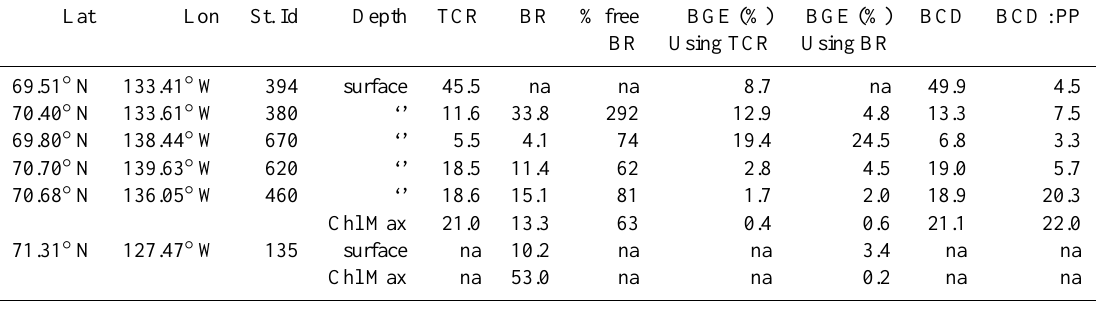
Table 2. Total community respiration (TCR, mgCm − 3 d − 1 ), free-living bacterial respiration (BRmgCm − 3 d − 1 ), percentage of respiration associated to free-living bacteria (%), bacterial growth efficiency (BGE, %), bacterial carbon demand (BCD, mgCm − 3 d − 1 ) and BCD to primary production (PP, mgCm − 3 d − 1 ) ratio.